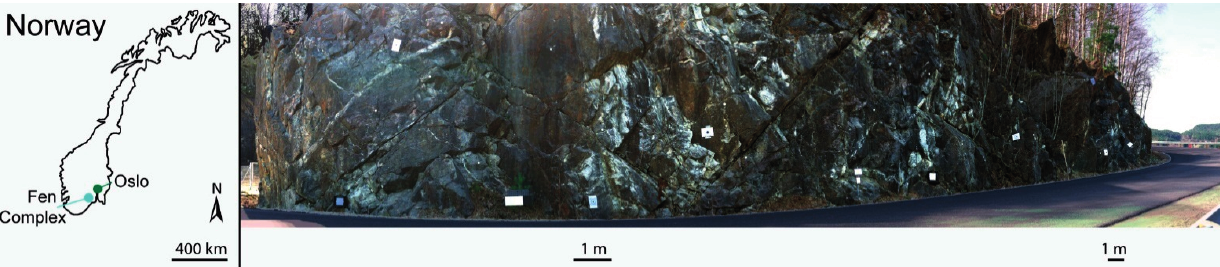
Figure 2. Map of Norway showing the location of the study area and a ~180 degree image that was collected as part of the HySpex data acquisition. The two scale bars below the outcrop image indicate a distance of one meter horizontally and represent their exact vertical locations. The image is compressed towards the edges because the rotational acquisition mode was used. The overview map is modified after Boesche et al. 2014